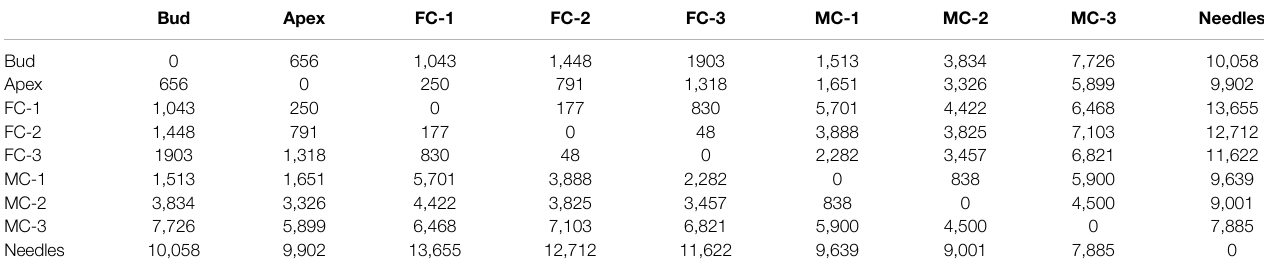
TABLE 2 | Differentially expressed transcripts comparison between samples. Cutoff Log2 fold change ≥ 2 and ≤ ( − 2), FDR 0.05, Apex, FC: female cones, MC: male cones. Bud Apex